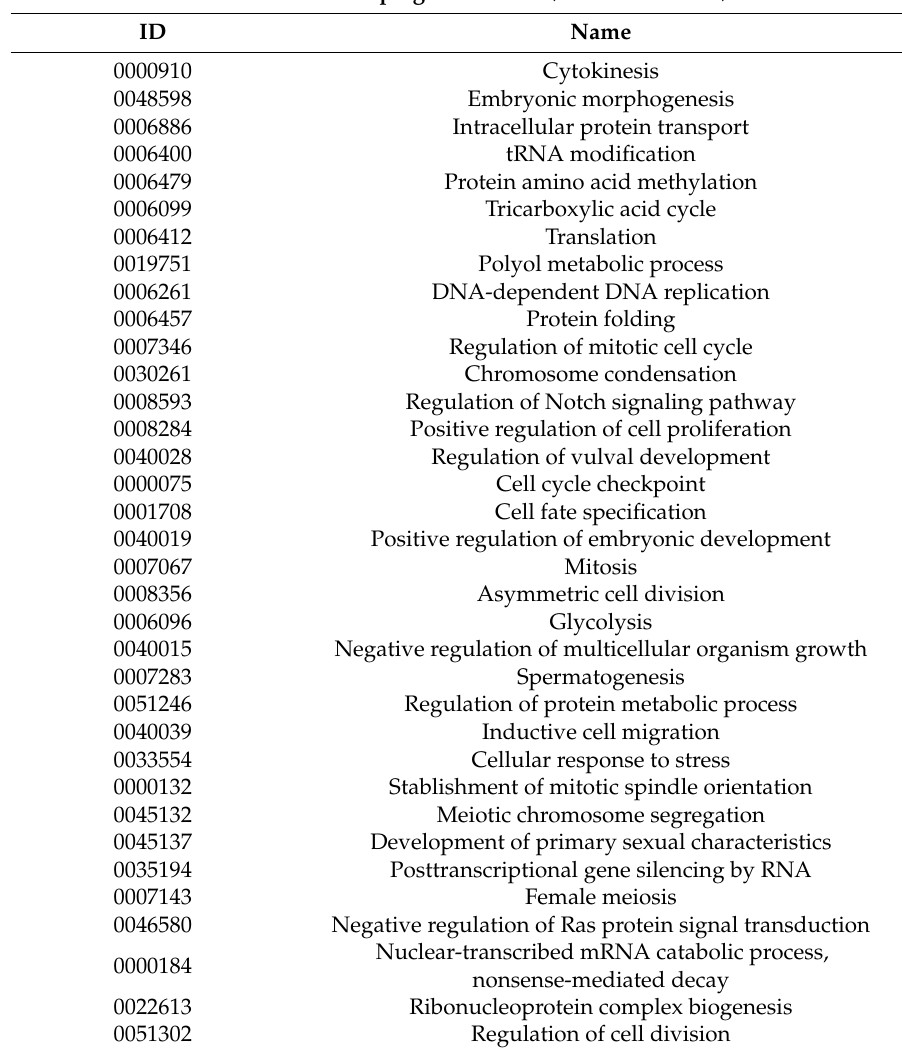
Table 3. GO Biological Processes was significantly ( p ≤ 0.05) non-redundantly upregulated in C. elegans N2 feeding with β -Cryptoxanthin (BCX) (0.025 µ g/mL) as compared with control feeding conditions. Non-Redundant Upregulated GOs (BCX vs.